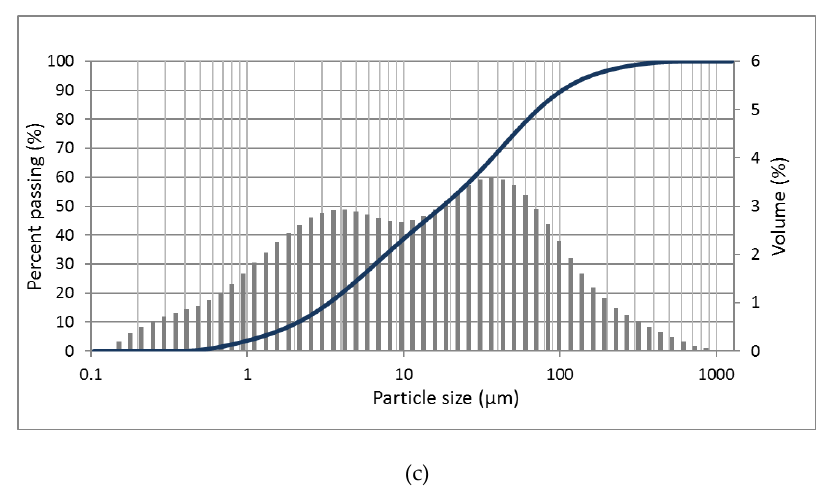
Figure 2. Raw materials’ particle size distribution ( a ) RFA, ( b ) CFA, and ( c ) BFA.